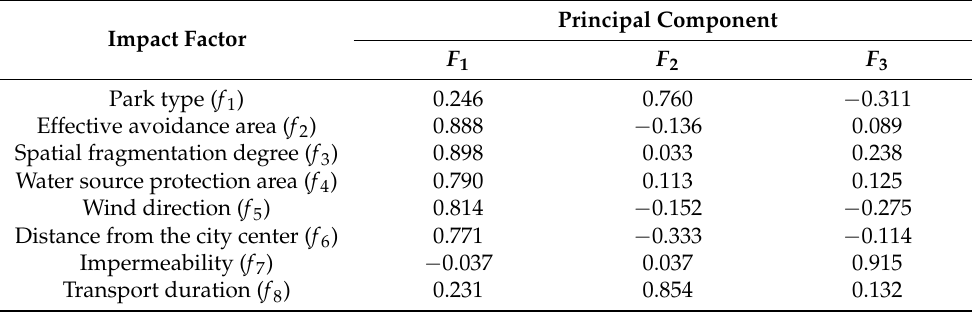
Table 2. Table of principal component load factors.